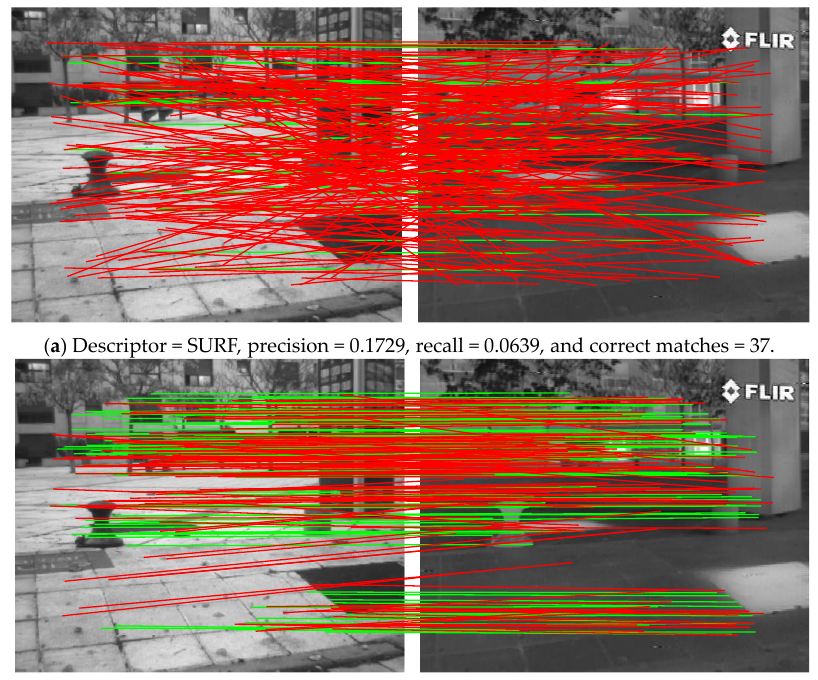
Figure 14. The average PR curves and F1-measure curve results for all the descriptors.